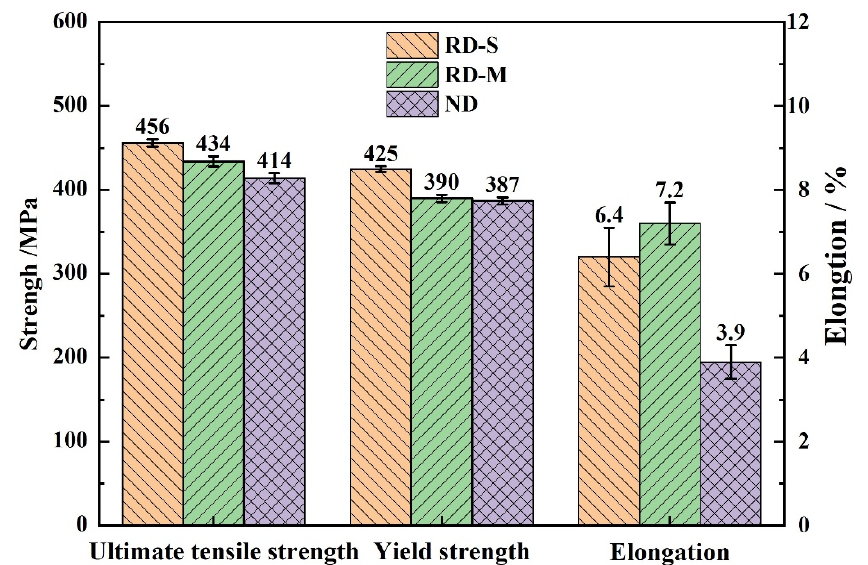
Figure 6. Tensile properties of the 2519A aluminum alloy.